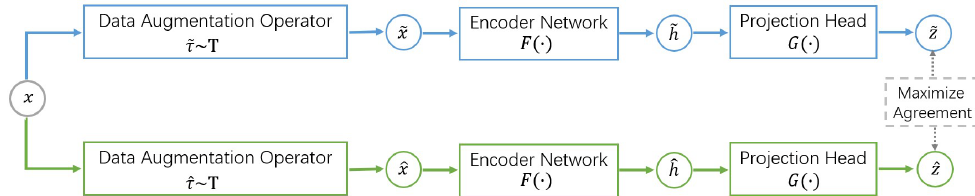
Figure 4. Contrastive learning pipeline for self-supervised